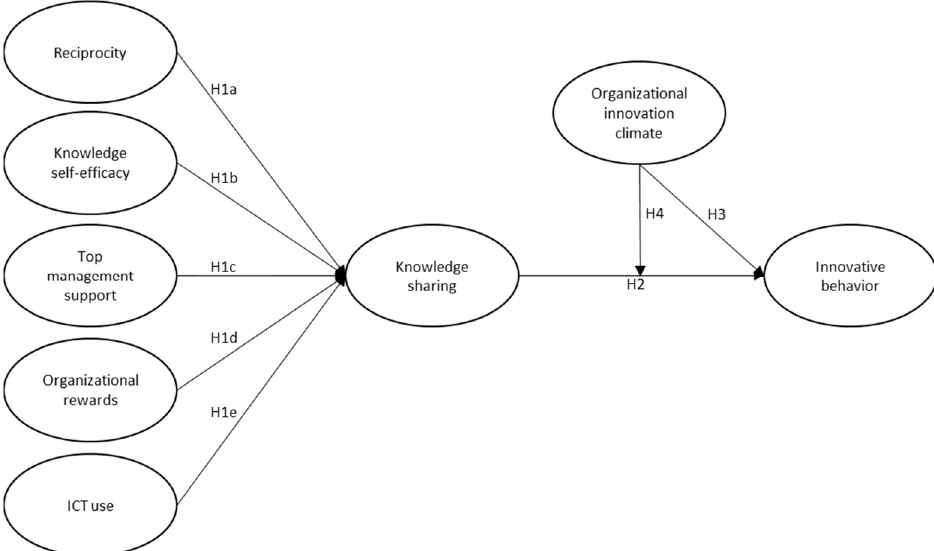
Figure 1. Conceptual framework. H1a: Reciprocity is positively related to KS; H1b: Knowledge self ‐ efficacy is positively related to KS; H1c: Top management support is positively associated with KS; H1d: There is a significant relationship between rewards and KS; H1e: Information